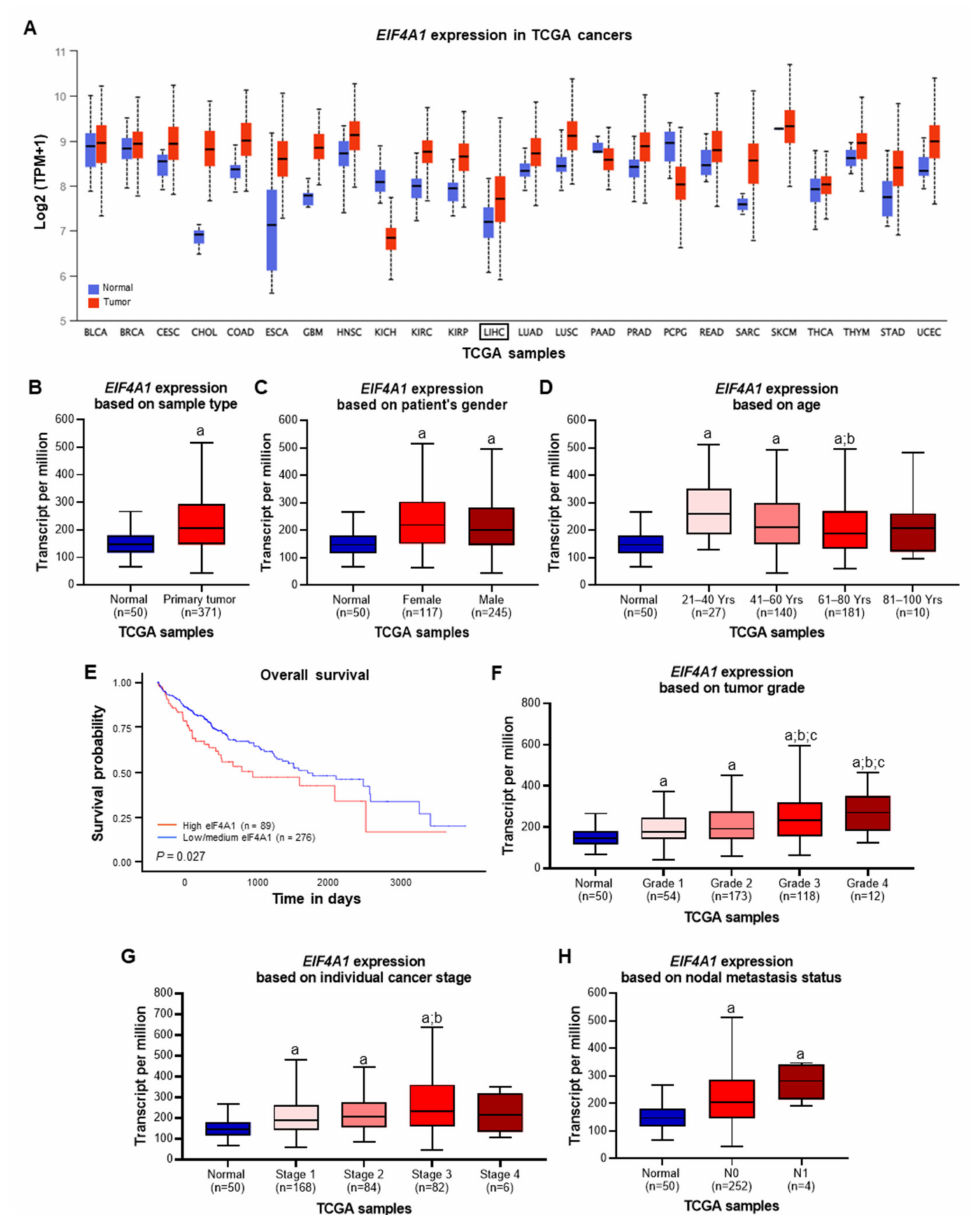
Figure 1. Biostatistical analysis from TGCA data of the eIF4A1 gene in various tumor types and human hepatocellular carcinoma (HCC). Please refer to the main text for detailed explanations. ( A ) mRNA levels of eIF4A1 in various tumor types, including liver hepatocellular carcinoma (LIHC). ( B ) mRNA levels of eIF4A1 in non-tumorous (normal) and HCC (primary tumor) specimens. ( C ) mRNA levels of eIF4A1 in HCC specimens based on gender. ( D ) mRNA levels of eIF4A1 in HCC specimens based on age (Yrs: Years). ( E ) Kaplan-Meier curves in HCC patients based on eIF4A1 mRNA levels. ( F ) mRNA levels of eIF4A1 in HCC specimens based on tumor grade (grade 1: well-differentiated; grade 2: moderately differentiated; grade 3: poorly differentiated; grade 4: undifferentiated). ( G ) mRNA levels of eIF4A1 in HCC specimens based on the individual cancer stage (stage 1: cancers localized to one part of the body; stage 2 and 3: locally advanced cancers; stage 4: spread to other organs and often metastasized cancers). ( H ) mRNA levels of eIF4A1 in HCC specimens based on nodal metastasis status (N0: no evidence of cancer in regional lymph nodes; N1: cancer has spread to a single lymph node near the